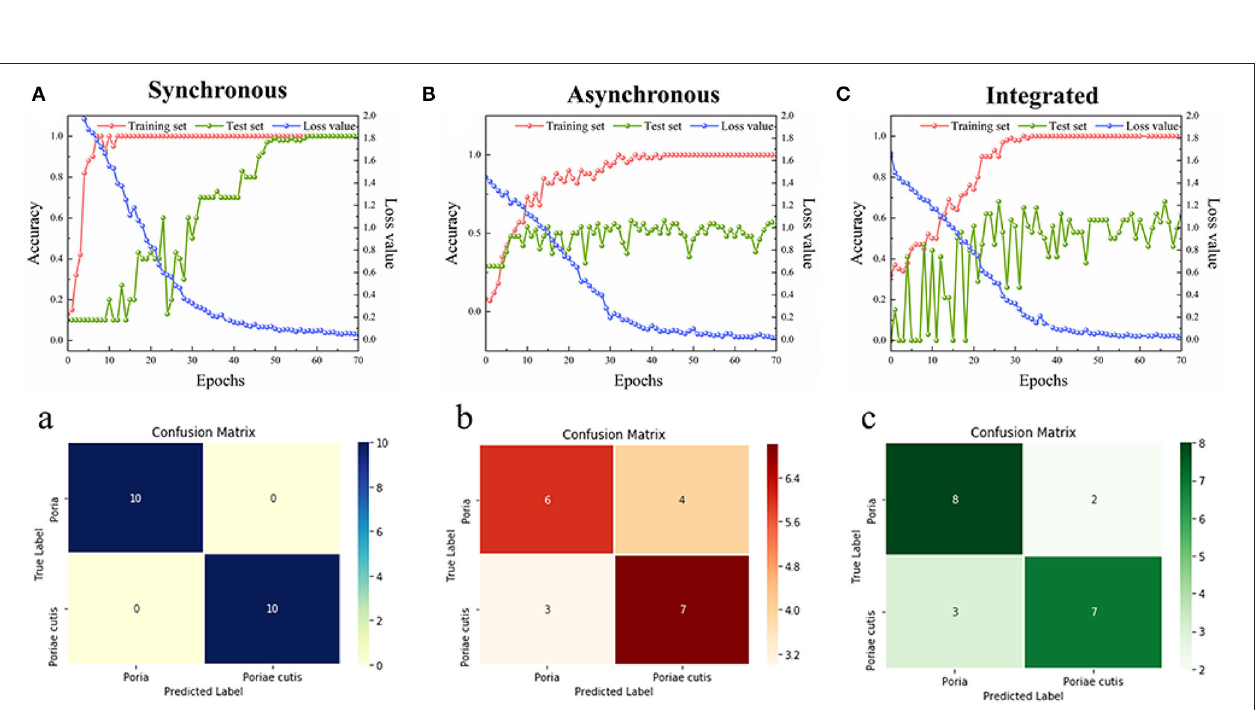
FIGURE 5 | (A–C) The accuracy curves and cross-entropy cost function of models based on W. cocos ; (a–c) The confusion matrix for external validation sets of models based on W. cocos .